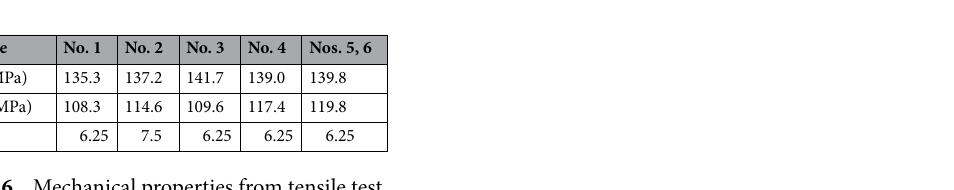
Table 6. Mechanical properties from tensile